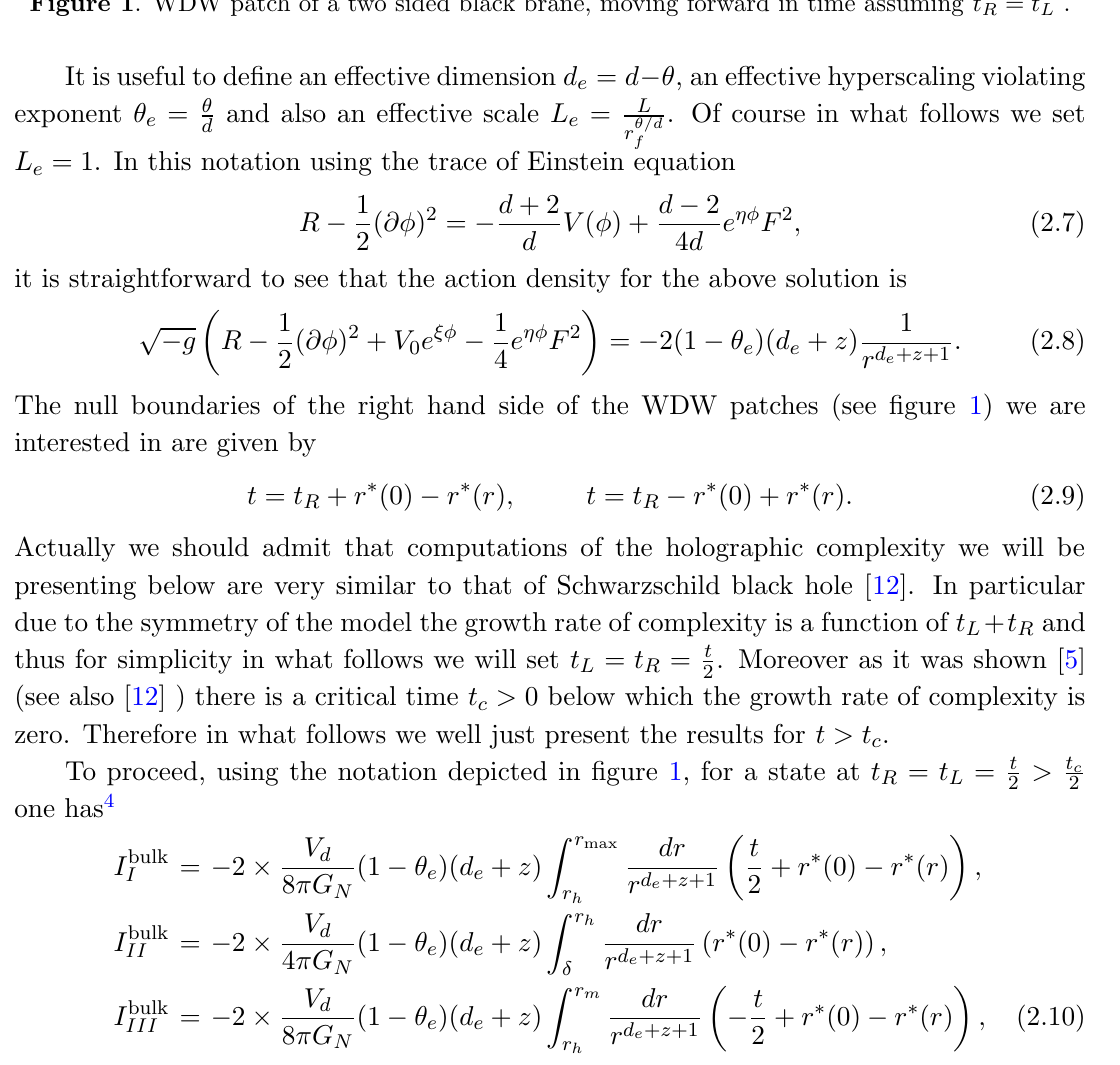
Figure 1 . WDW patch of a two sided black brane, moving forward in time assuming t